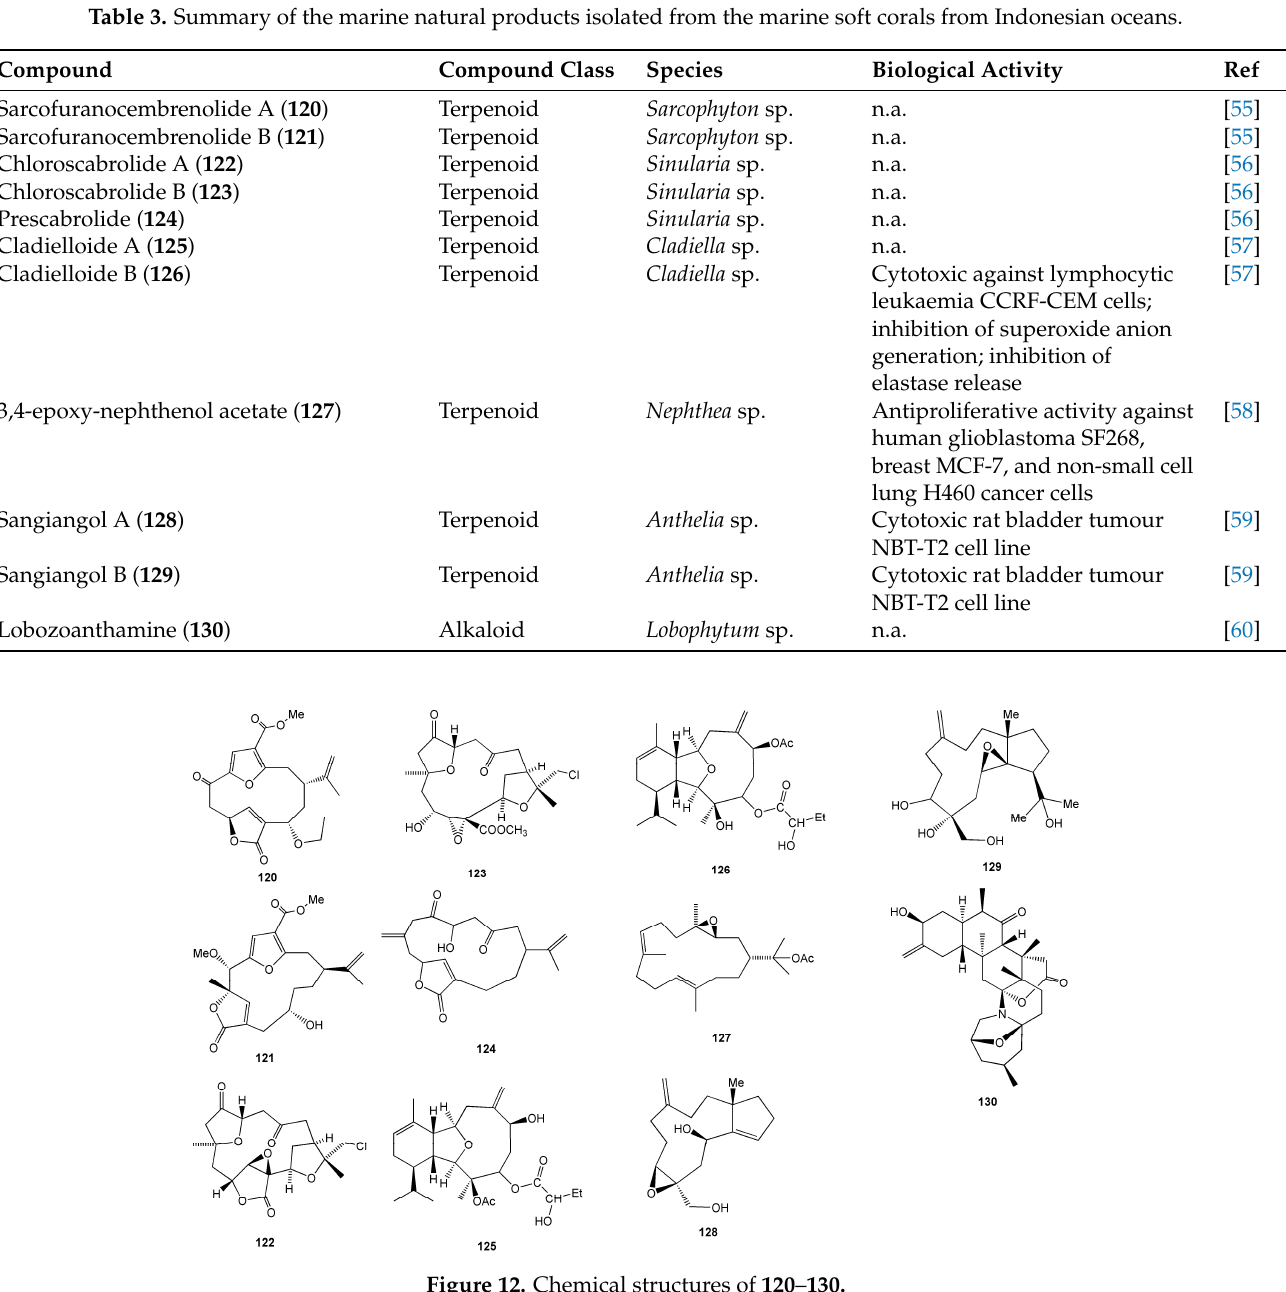
Figure 12. Chemical structures of 120 – 130.